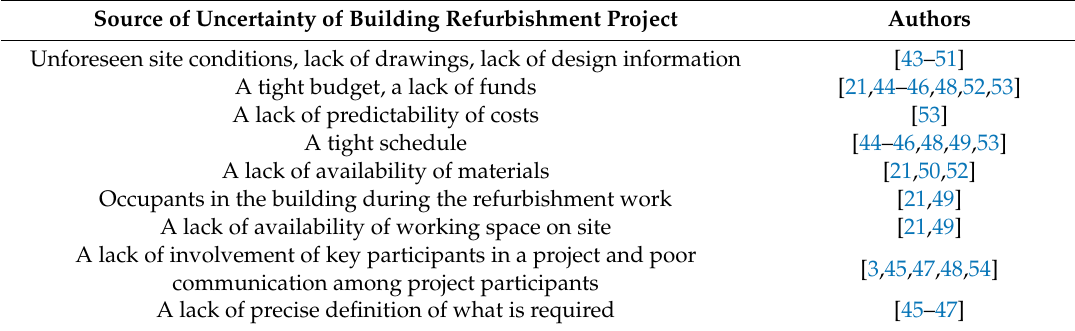
Table 1. The sources of uncertainty of building refurbishment